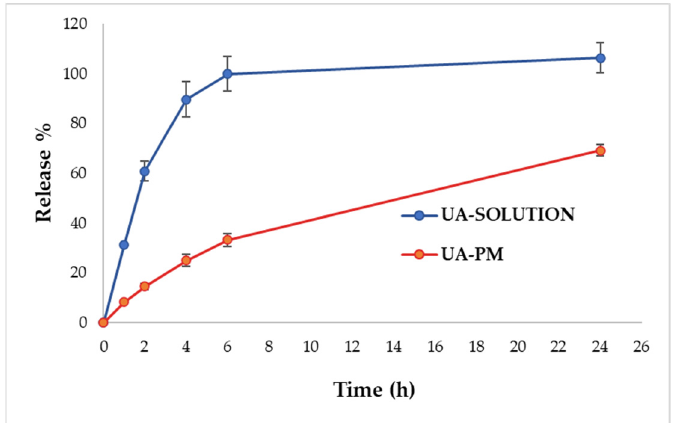
Figure 3. In vitro release profiles of UA from solution and from UA–PM in PBS:EtOH 70:30. Data are reported as mean ± SD of n = 3 experiments.